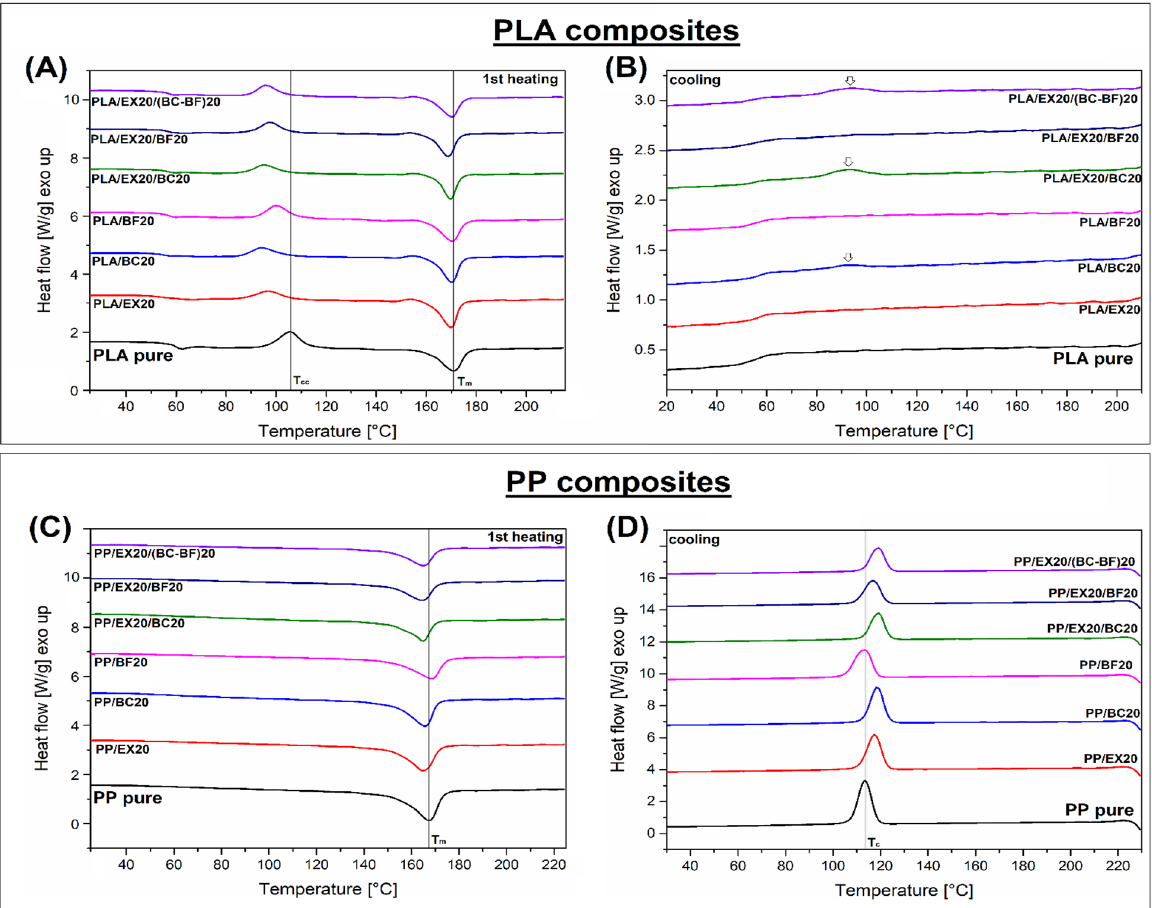
Figure 6. The DSC thermograms of ( A , B ) PLA and ( C , D ) PP-based materials. Plots present the 1st heating and cooling signals.